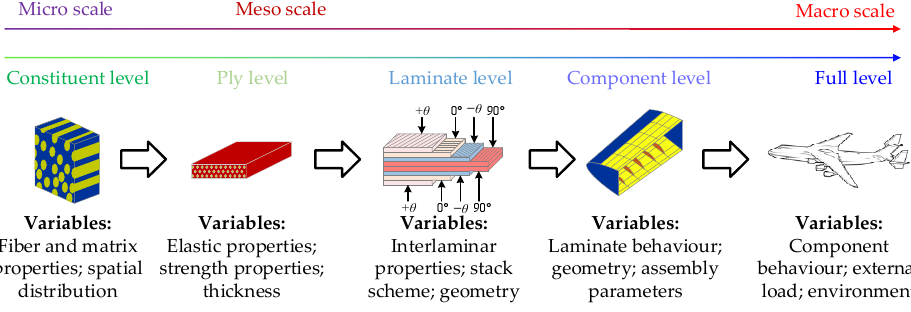
Figure 1. The transfer of uncertain mechanical properties from the constituent level to the full vehicle level.